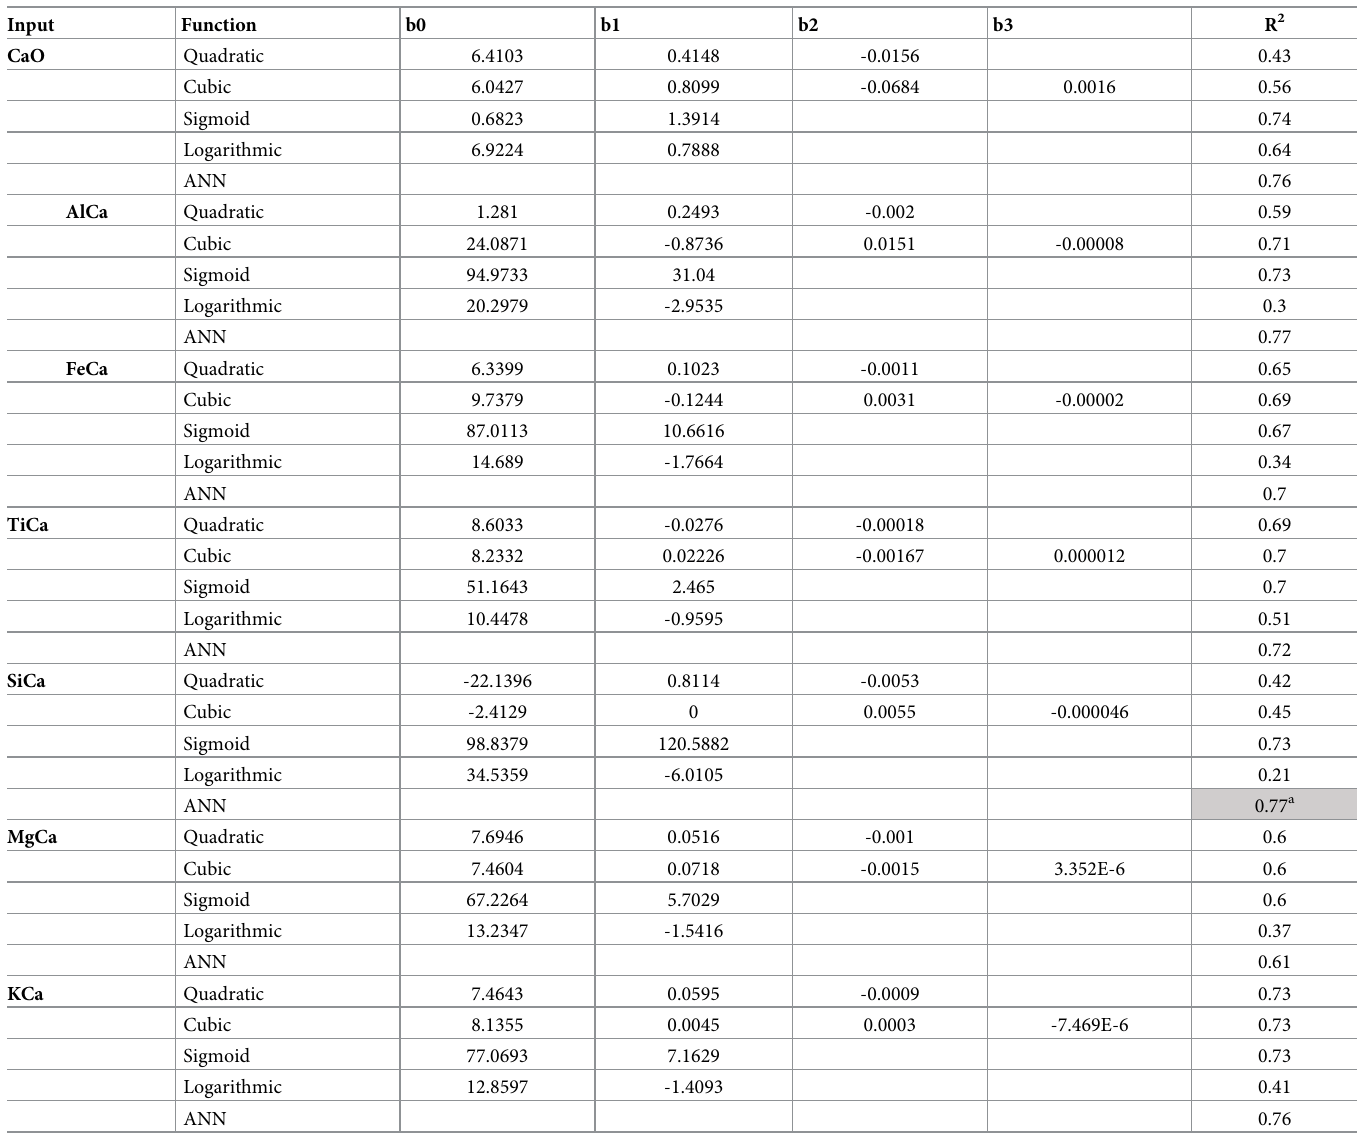
Table 5. Model calibration (N = 877, p <